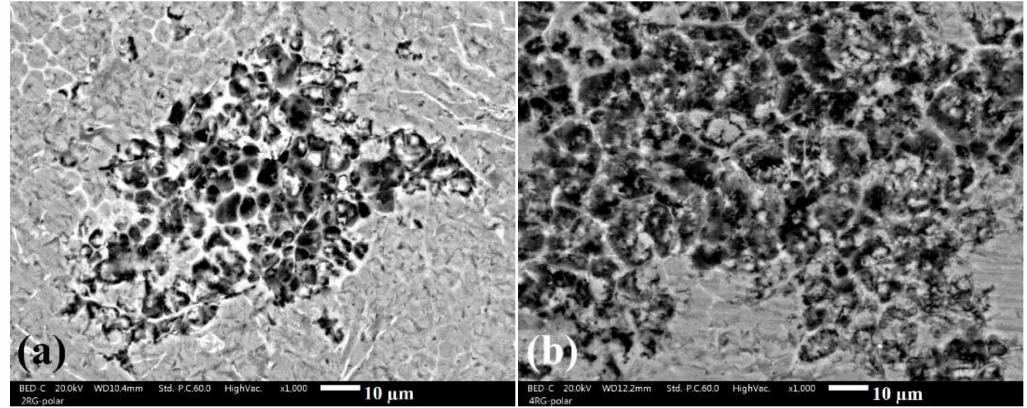
Figure 11. Corroded surfaces of sample ( a ) 2.5 RG and ( b ) 4.5 RG after polarization test in the diluted Harrison